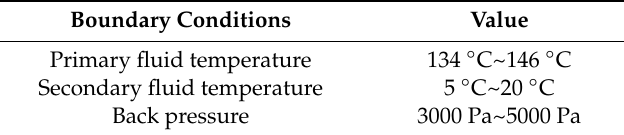
Table 2. Flow conditions of the steam ejector.